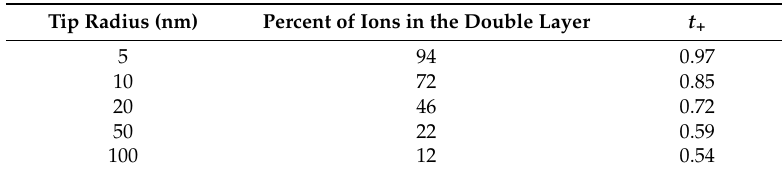
Table 2. Calculations of the fractions of the total number of moles of ions that are double layer cations and of the transference numbers at the tip of different pore tip radii.